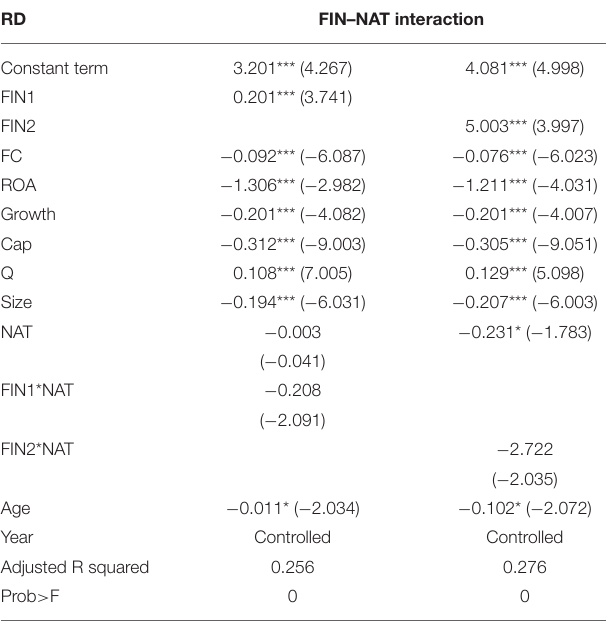
TABLE 8 | Monthly estimation results of Chinese strategic emerging industries trade values.